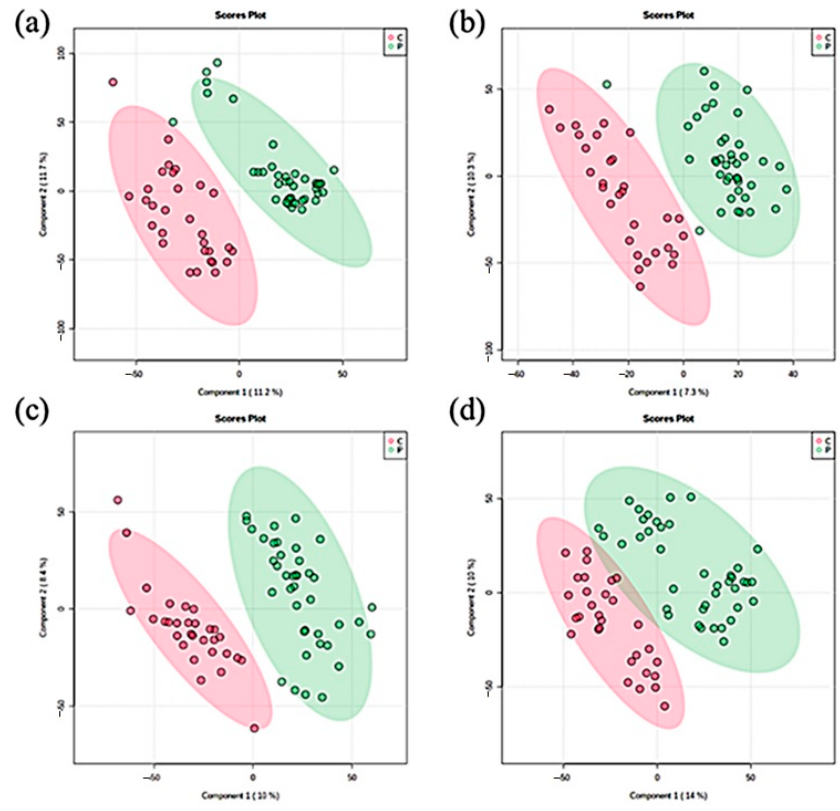
Figure 1. Partial least squares discriminant analysis (PLS-DA) score plots showing discriminant different patterns in controls (red circles) and pattern baldness patients (green circles). ( a ) PLS-DA in positive mode with male groups, ( b ) PLS-DA in negative mode with male groups, ( c ) PLS-DA in positive mode with female groups, and ( d ) PLS-DA in negative mode with female groups.